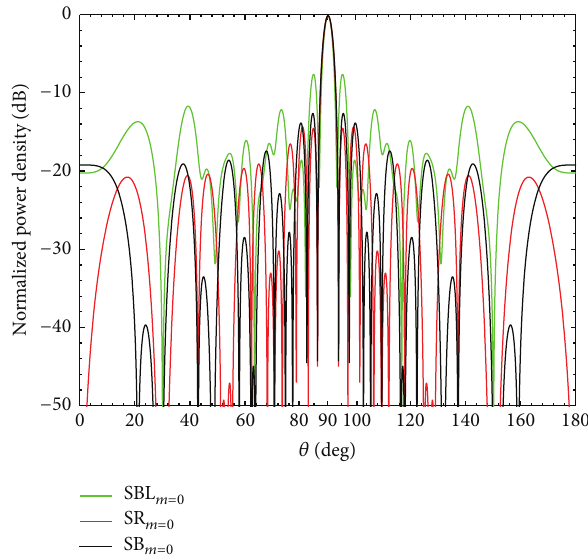
Figure 6: Radiation patterns at carrier frequency and at first harmonic related to Figure 5 for IS—the 𝑚 subscript represents the harmonic number. (Since all sidebands are below -50 dB (see Figure 7), they are not shown in this